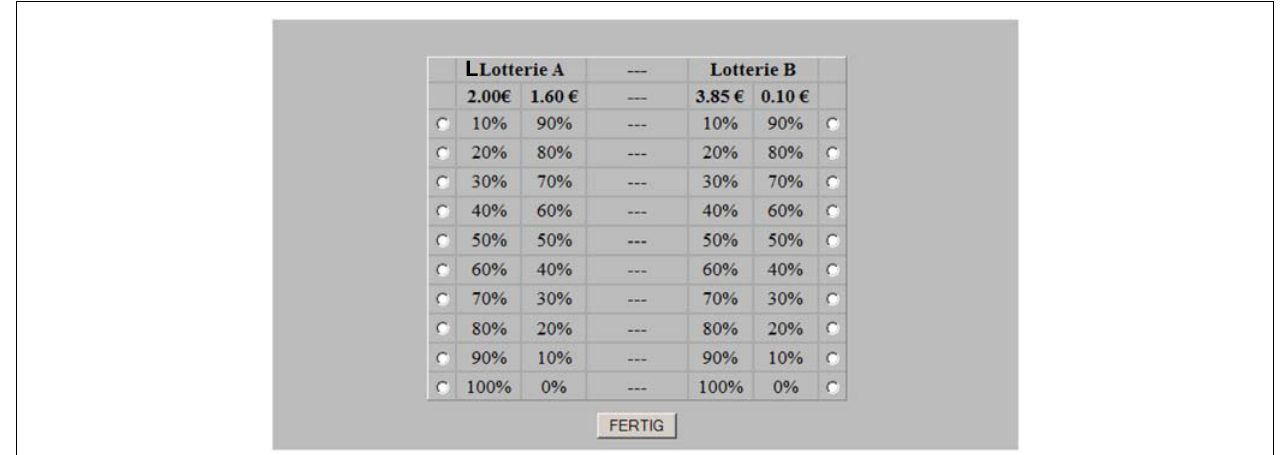
FIGURE 1 | Screenshot of the matrix version in which all the iterations were presented simultaneously. In the sequential version (not displayed here), only one iteration was presented at a time.